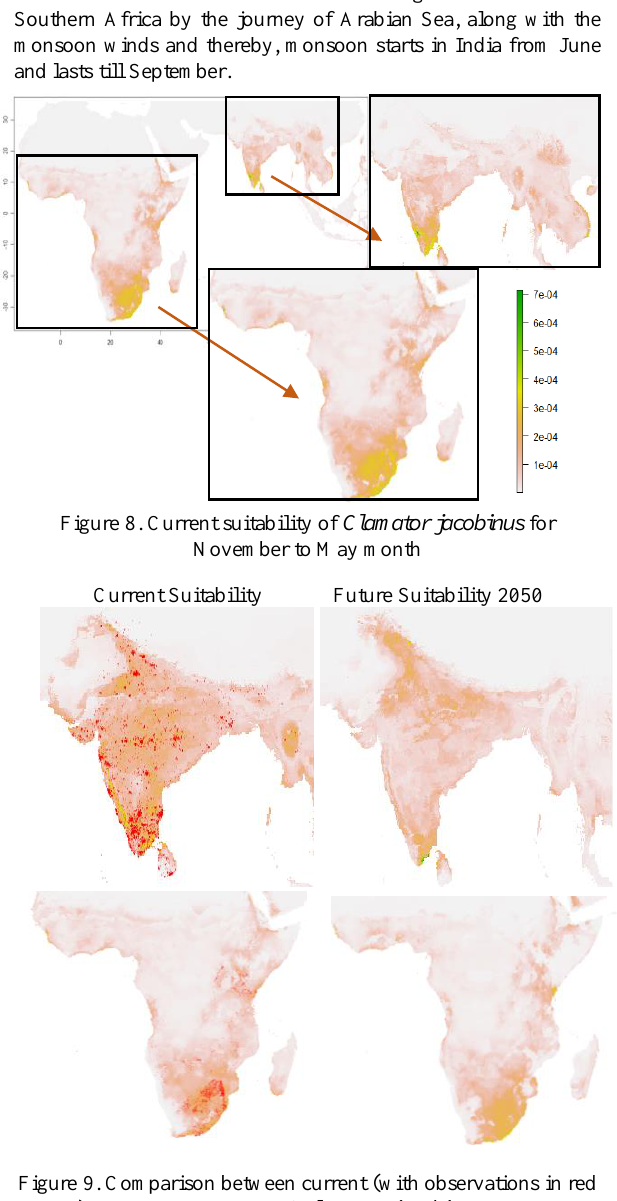
Figure 9. Comparison between current (with observations in red points) and 2050 suitability of Clamator jacobinus in India and Southern Africa